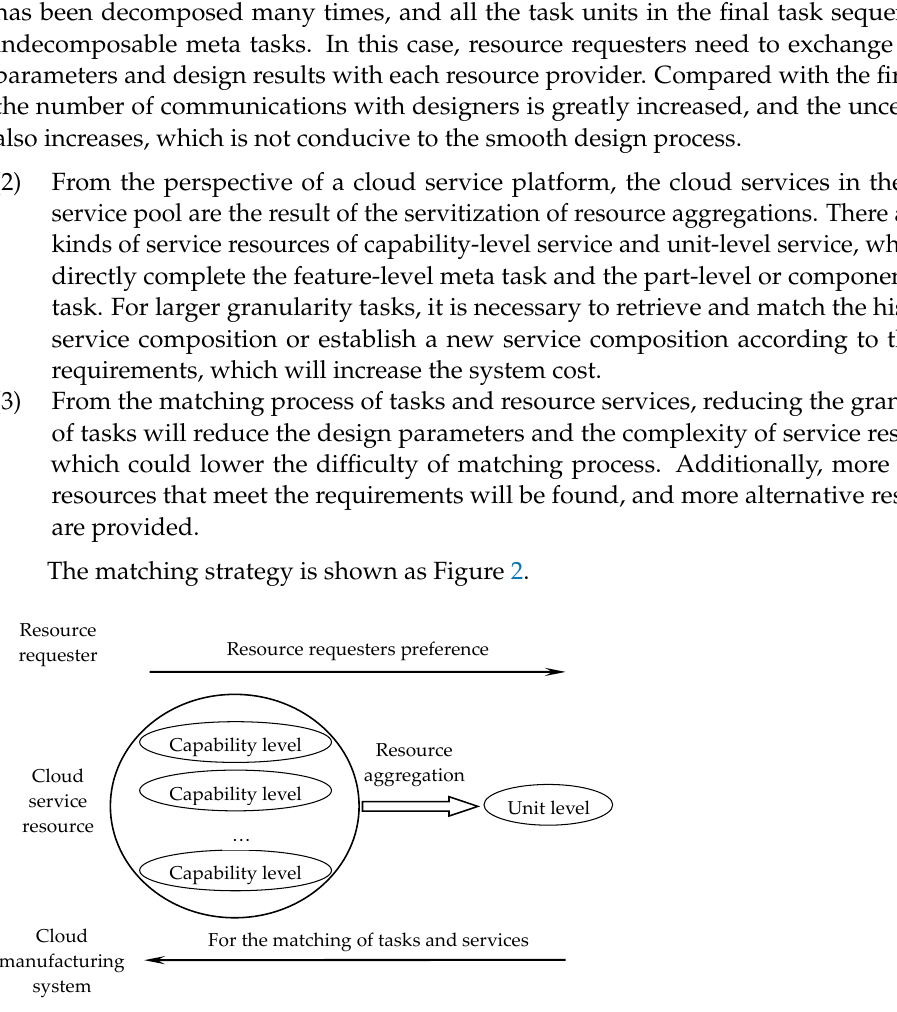
Figure 2. The matching